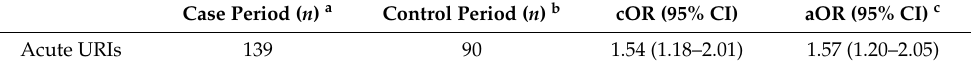
Table 2. Conditional Logistic Regression Models of Acute URIs and Risk of SSNHL within 1